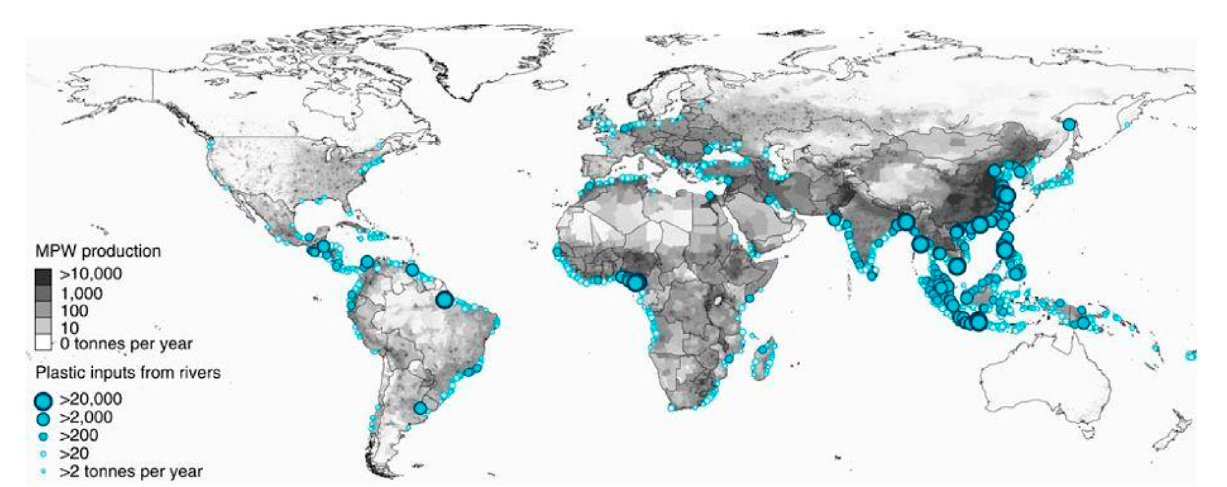
FIGURE 2 Massofriverplastic fl